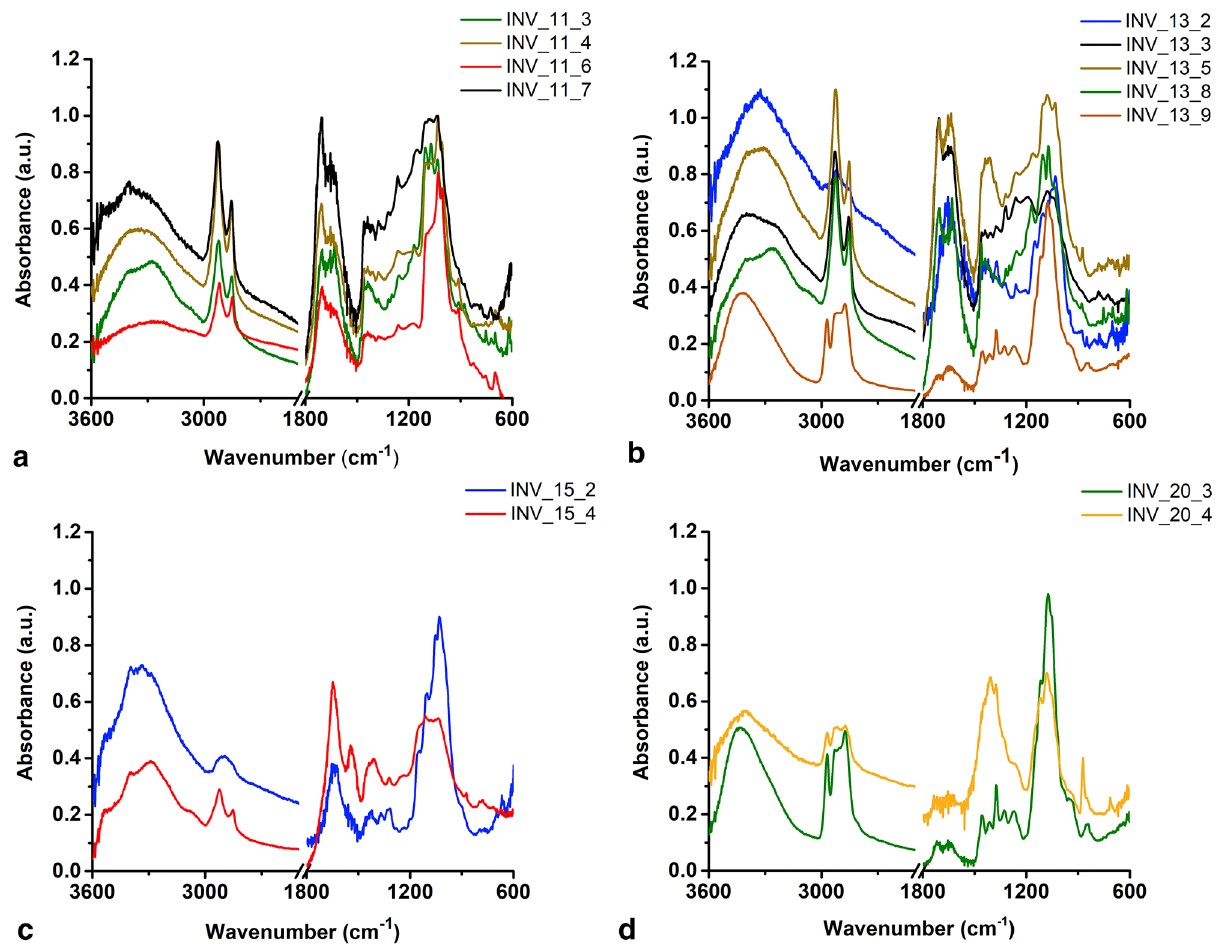
Figure 2. µATR-FTIR spectra performed on the wallpapers. The spectra were collected on the selected sampling points (as indicated in the legend) of ( a ) INV_11, ( b ) INV_13, ( c ) INV_15, and ( d ) INV_20. For clarity, the µATR-FTIR spectra were offset of 0.10 arbitrary units